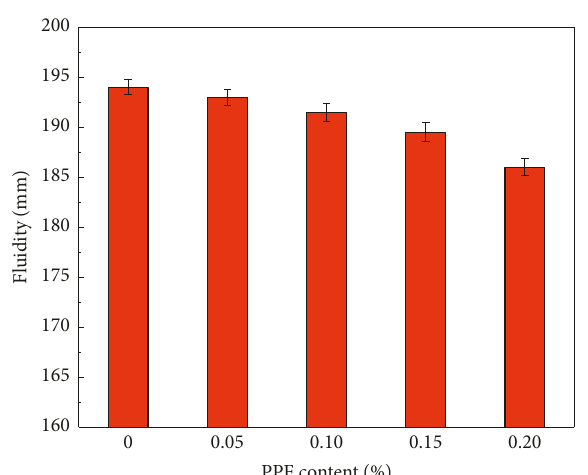
Figure 3: Evolution of the fluidity of AAS mortars as function of PPF content. The error bars represent the standard deviation of three test specimens.